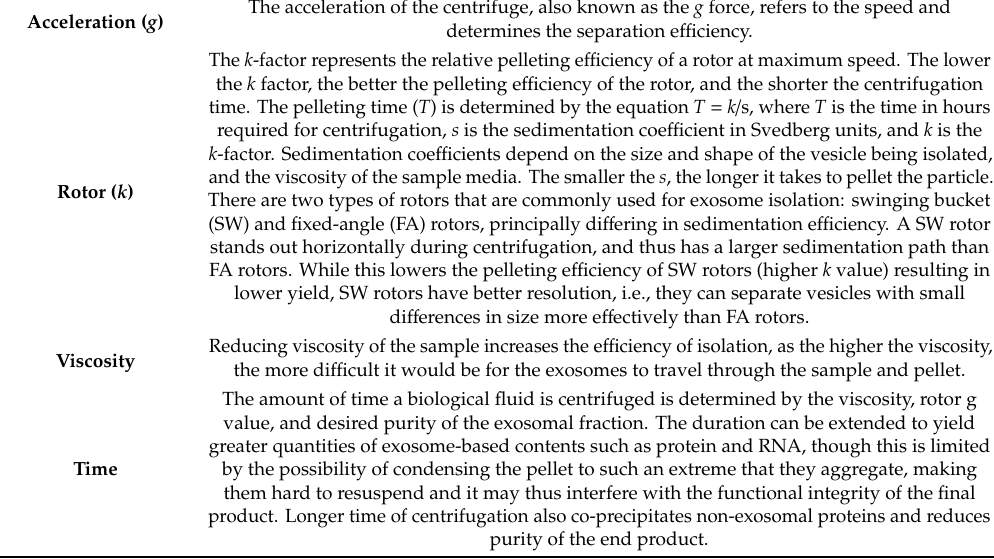
Table 3. Factors that a ff ect di ff erential ultracentrifugation (dUC)-based exosome isolation. The e ffi ciency of exosome isolation using di ff erential ultracentrifugation is governed by four main factors: acceleration, the type of rotor in which the samples are placed, the viscosity of the solution in question, and finally the time needed to create the desired pellet [53]. This table summarizes each variable and considerations